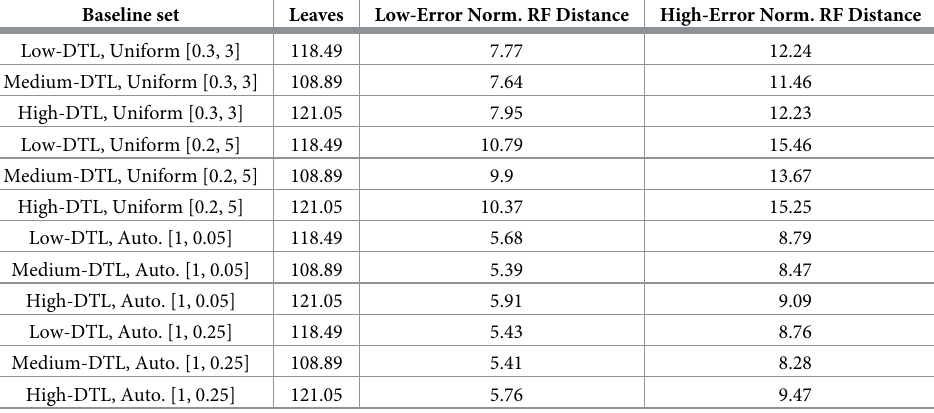
Table 2. Error-rates for reconstructed gene trees. Average Robinson-Foulds distance for the 12 sets of low-error reconstructed baseline gene trees and the 12 sets of high-error reconstructed baseline gene trees. Results are averaged across the 100 gene trees in each set. The table also shows the average number of leaves in each data set. Baseline set Leaves Low-Error Norm. RF